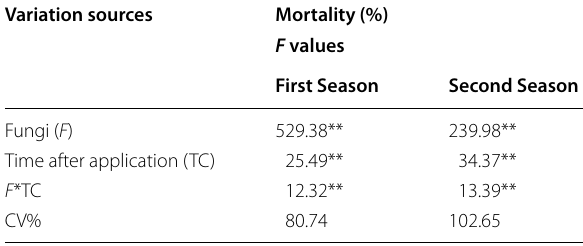
Table 1 Synthesis of the analysis of variance for Helicoverpa armigera mortality in the first and second seasons of the field trials